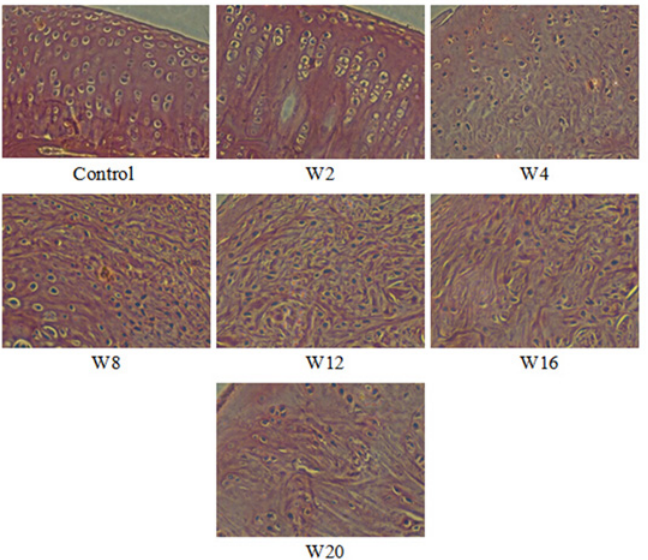
12, 16, and 20 weeks after surgery, respectively.